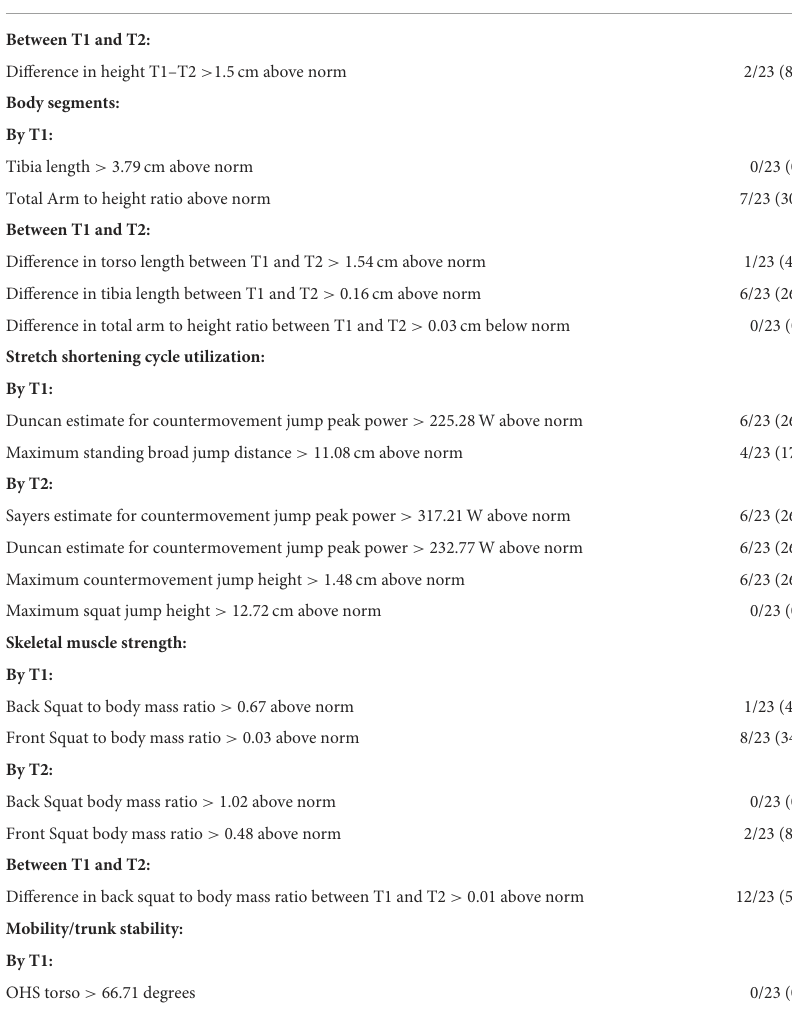
TABLE 5 Logical attributes for all discriminative features within anthropometrics and physiology. Attribute Low performing High performing OR (95% CI)